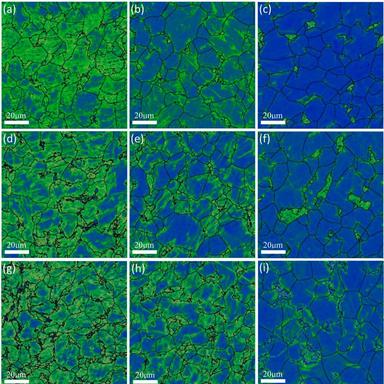
EBSD KAM images of 1440–600 sample after tensile deformation of (a–c) 2%, (d–f) 4%, (g–i) 6%. (a, d, g) r = 1.0 R, (b, e, h) r = 0.5 R, (c, f, i) r = 0 R.